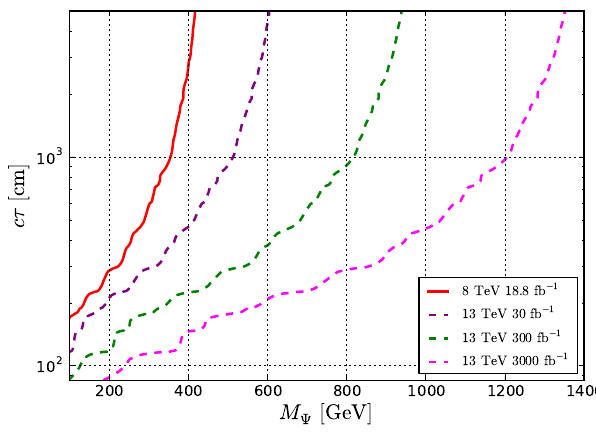
Figure 16 . The 8 TeV (solid) and projected 13 TeV (dashed) limits from HSCP searches at the LHC for pair-production of the fermionic co-annihilation partner, (cid:9) (cid:6) . The projected limits correspond to the 13 TeV LHC with 30, 300 and 3000 fb (cid:0) 1 integrated luminosities.